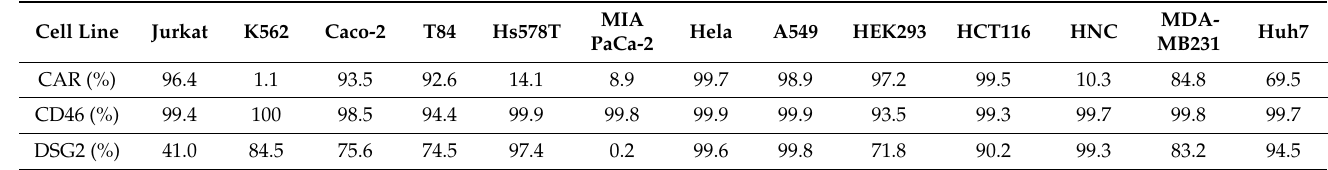
Table 1. Expression levels of the major adenovirus receptors on the cell surfaces of the cell lines used in this